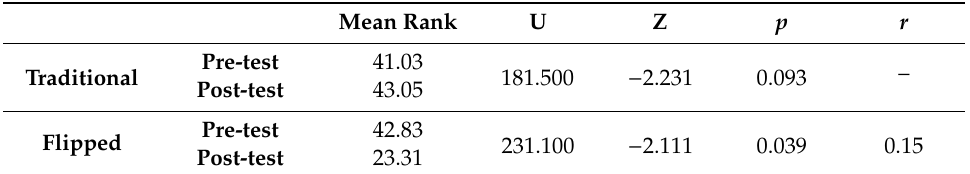
Table 6. Mann–Whitney U test for learning motivation dimension.